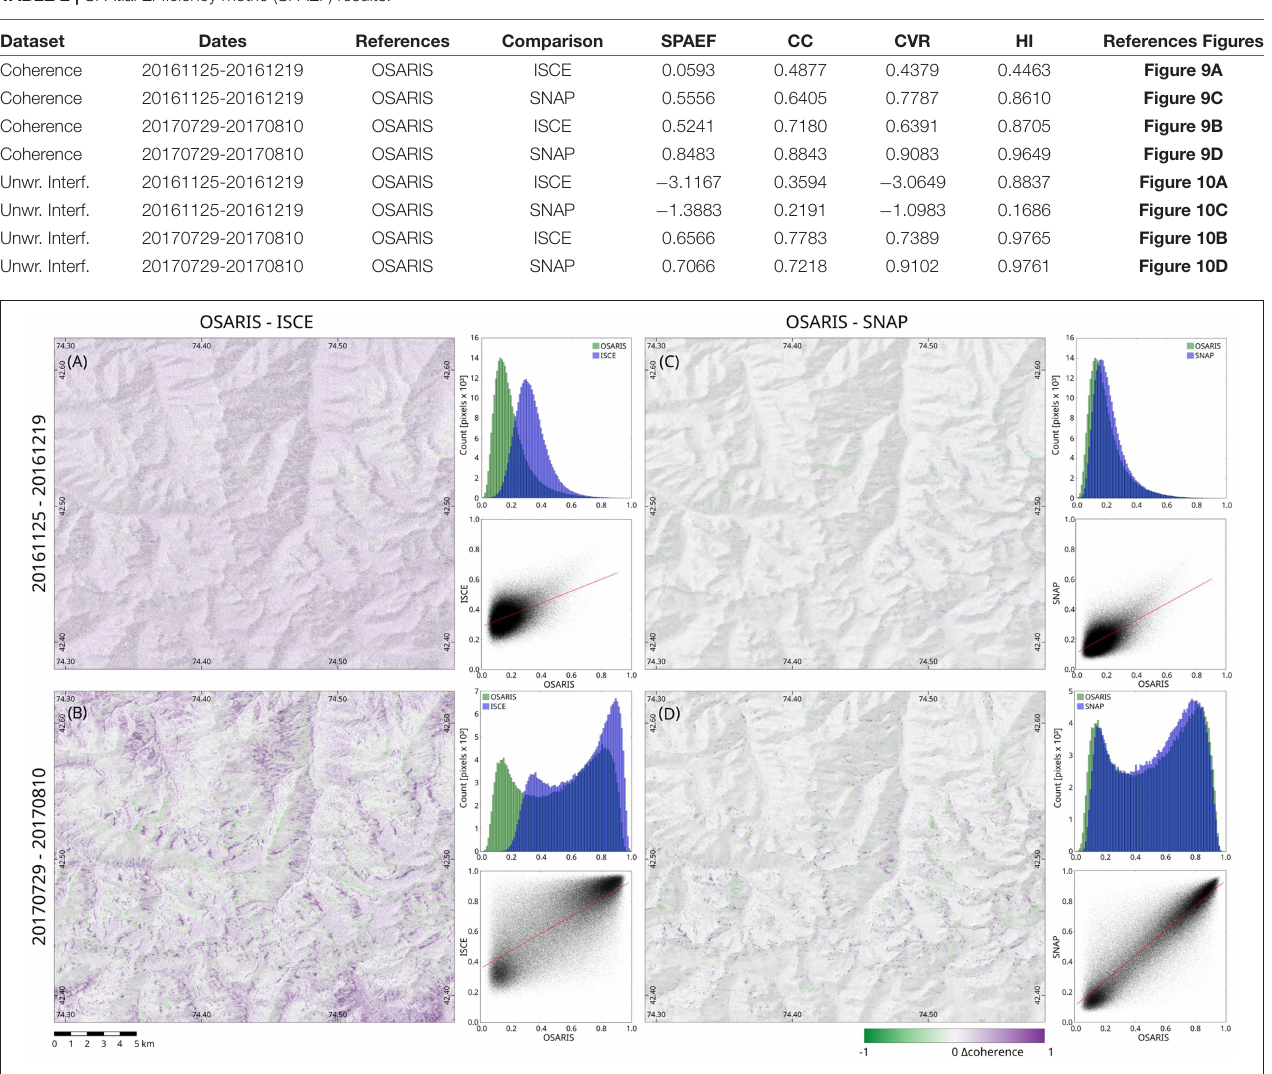
FIGURE 9 | Differences in coherence and corresponding SPAtial Efficiency metric results (histograms, scatter plots) for the core study area. (A) OSARIS—ISCE for the low-coherence pair 2016-11-25 to 2016-12-19, (B) OSARIS—ISCE for the high-coherence pair 2017-07-29 to 2017-08-10, (C) OSARIS—SNAP for the low-coherence pair 2016-11-25 to 2016-12-19, (D) OSARIS—SNAP for the high-coherence pair 2017-07-29 to 2017-08-10. Difference images for the wider study area are available in Figure S3 , the respective coherence results from the individual processors in Figure S4 . A semitransparent hillshade based on SRTM DEM data was added for orientation. Contains modified Copernicus Sentinel data 2016,